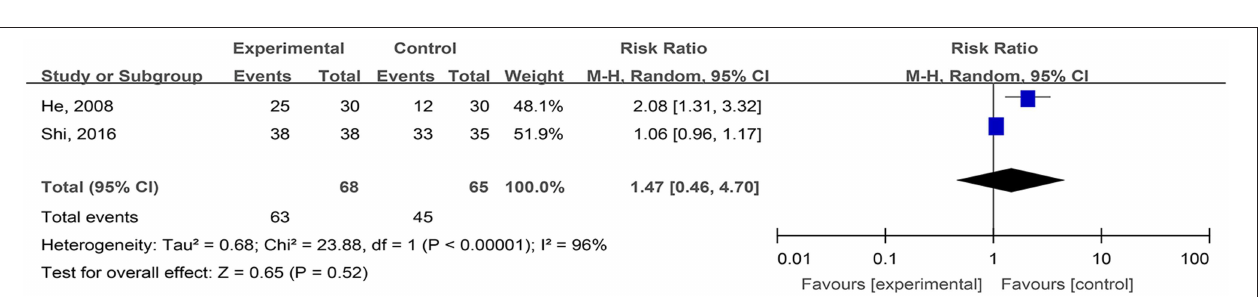
FIGURE 11 | Comparative meta-analysis of healing times of radioactive skin injuries.